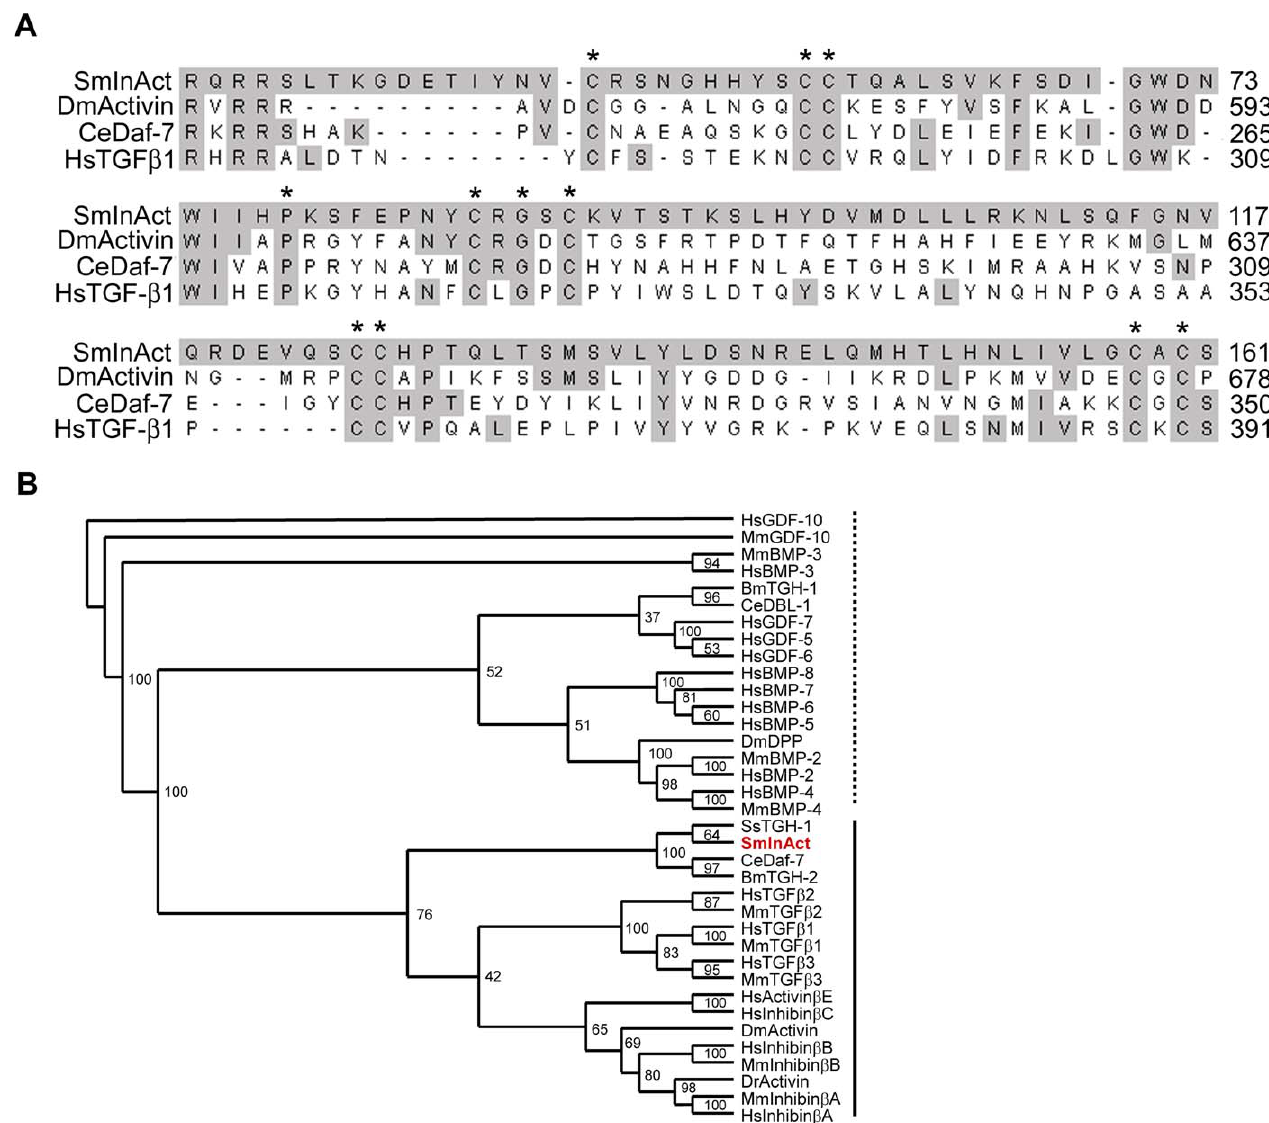
Figure 1. SmInAct Is a Member of the TGF- b /Activin Subfamily (A) ClustalW alignment of the C-terminal domain of the SmInAct protein with three other members of the TGF- b /Activin subfamily. Amino acids identical to the SmInAct sequence are shaded gray. Numbers to the right indicate position of the last amino acid in the row within each respective full- length sequence. Stars indicate invariant amino acid residues in TGF- b homologs. (B) Phylogenetic dendrogram demonstrating that SmInAct is a member of the TGF- b superfamily. SmInAct (red) is shown clustering among members of the TGF- b /Activin subfamily (solid line), and not with members of the BMP/growth differentiation factor subfamily (dashed line). Conserved residues in the C-terminal region of each homolog (final 94–106 amino acids) were used in the analysis. Percentages at branch points are based on 1,000 bootstrap runs.